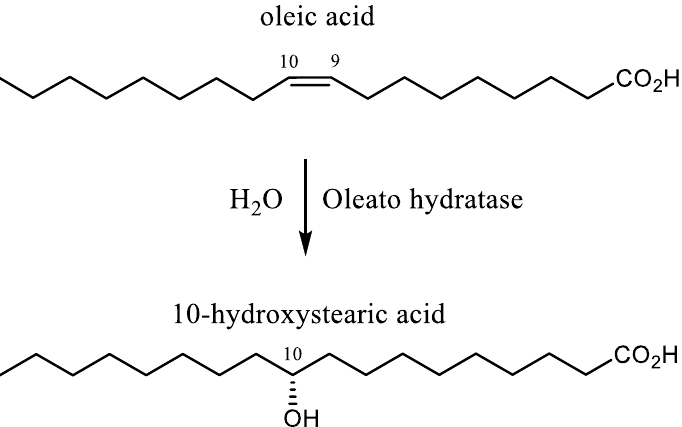
Figure 1. The hydration of oleic acid catalyzed by oleate hydratase.